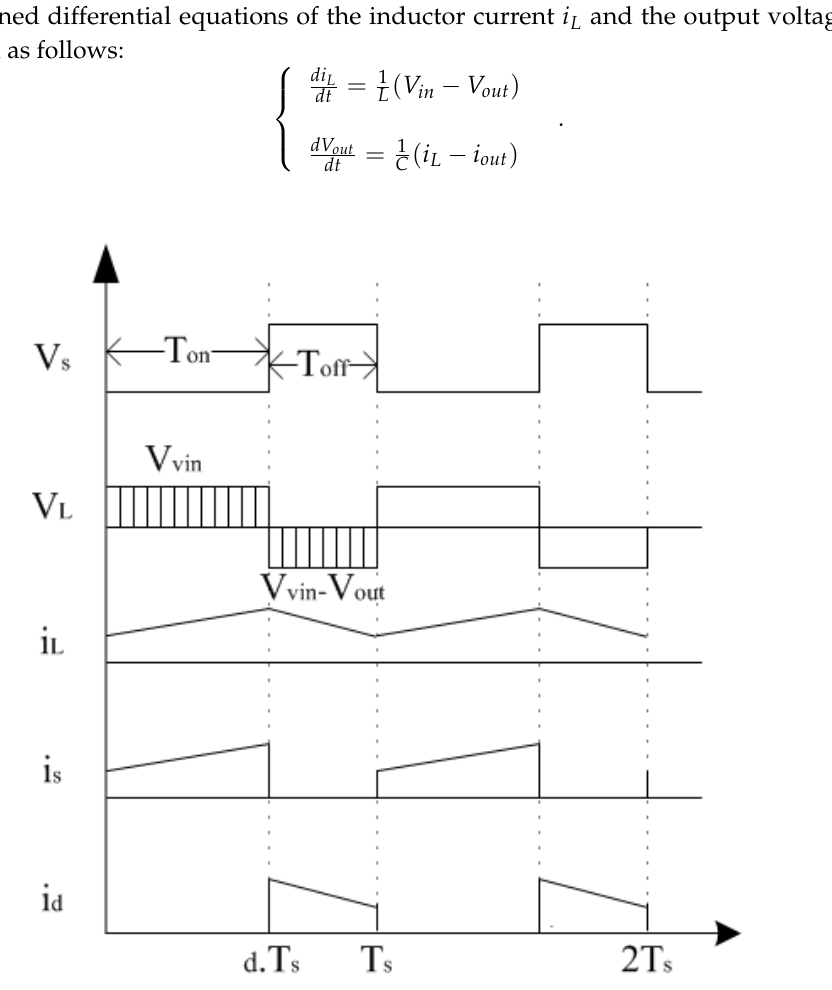
Figure 5. Waveforms of different currents and voltages under continuous conduction mode (CCM)